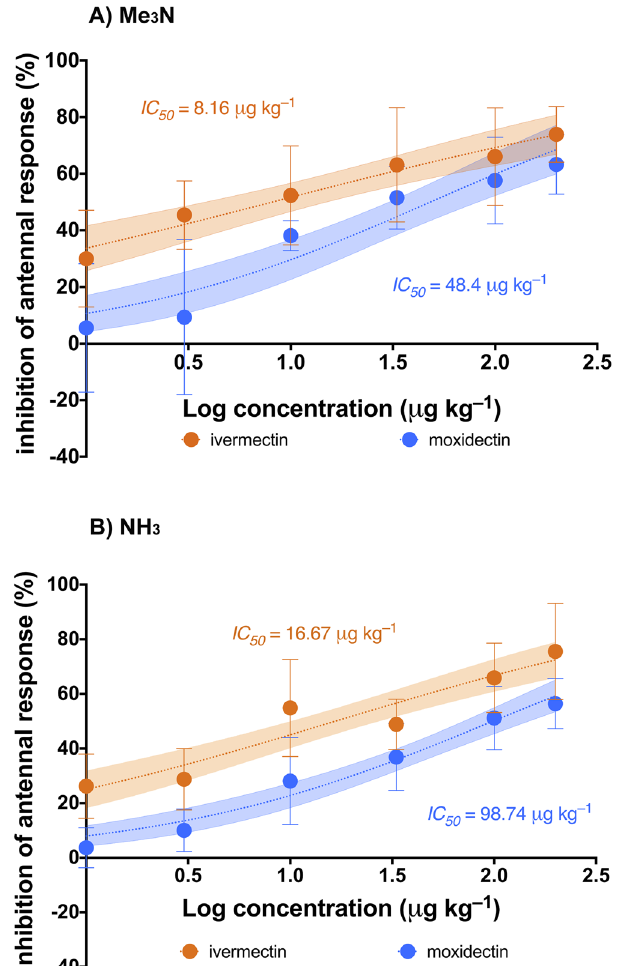
Figure 2. Concentration response curves for inhibition of antennal response by ivermectin (IVM) and moxidectin (MOX), using trimethylamine ( A ) and ammonia ( B ) as test odorants. Bars represent ± SD (n = 8). Shaded areas represent the 95% confidence intervals of each model. IC 50 corresponds to the concentration of each ML that inhibited 50% of antennal response. Statistical results of the effect concentrations (IC 50 ) by MLs for each odorant are provided in Table